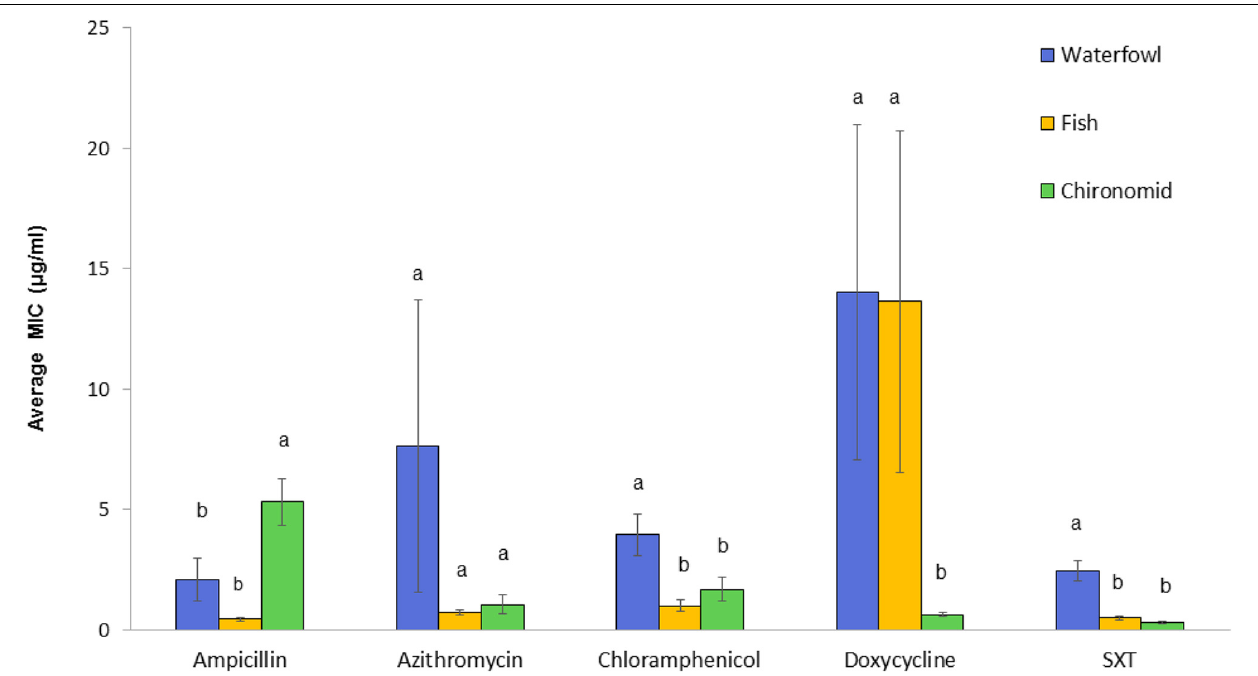
FIGURE 2 | Comparative analysis of MICs (average ± std. error) for each of the studied antimicrobial agents toward V. cholerae strains that were isolated from the three environmental reservoirs (waterfowl n = 47, fish n = 50, and chironomids n = 50). Bars with different letters are significantly different by One-way ANOVA with Tukey HSD test ( p < 0.05). SXT, Trimethoprim (TMP) and